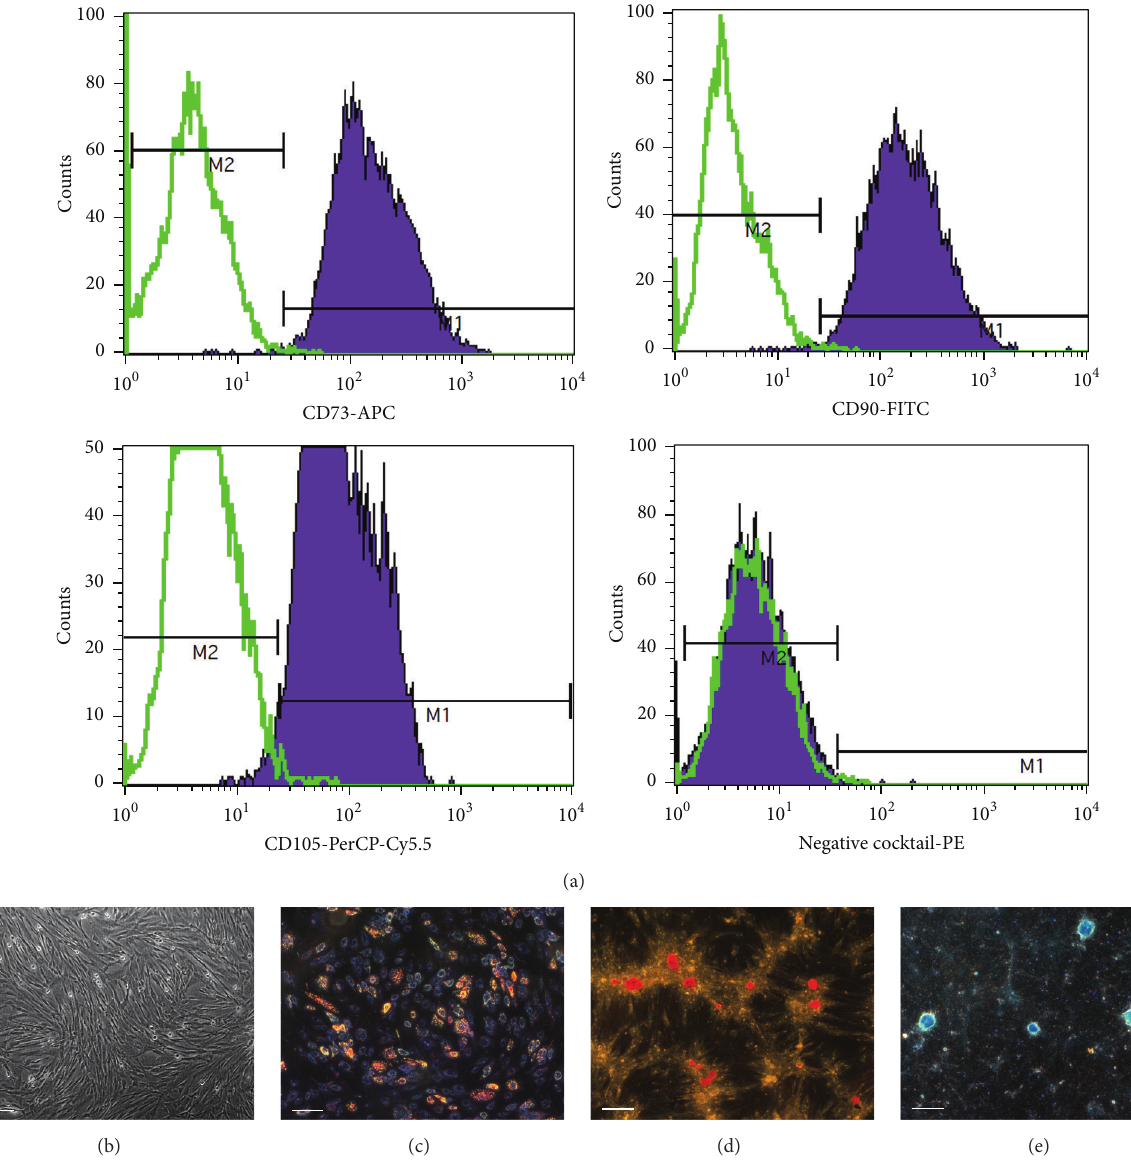
Figure 2: The characteristics of cultured cells derived from Wharton’s jelly according to minimal criteria to define human MSCs proposed by ISCT. (a) Analysis of immunophenotype with BD Stemflow (cid:2) hMSC Analysis Kit (BD Biosciences). Negative MSC cocktail includes PE CD45, PE CD34, PE CD11b, PE CD19, and PE HLA-DR antibody conjugates. (b) Phase contrast capture of UC-MSCs at the fourth passage. Scale bar: 200 𝜇 m. (c) Adipogenic differentiation with StemPro (cid:3) Adipogenesis Differentiation Kit (Gibco). Lipid droplets are stained with Sudan III. Scale bar: 200 𝜇 m. (d) Osteogenic differentiation with StemPro Osteogenesis Differentiation Kit (Gibco). Calcificated nodules are stained with Alizarin red S (pH = 4.1 ). Scale bar: 200 𝜇 m. (e) Chondrogenic differentiation with StemPro Chondrogenesis Differentiation Kit (Gibco). Mucopolysaccharides are stained with Alcian blue (pH = 2.5 ). Scale bar: 200 𝜇